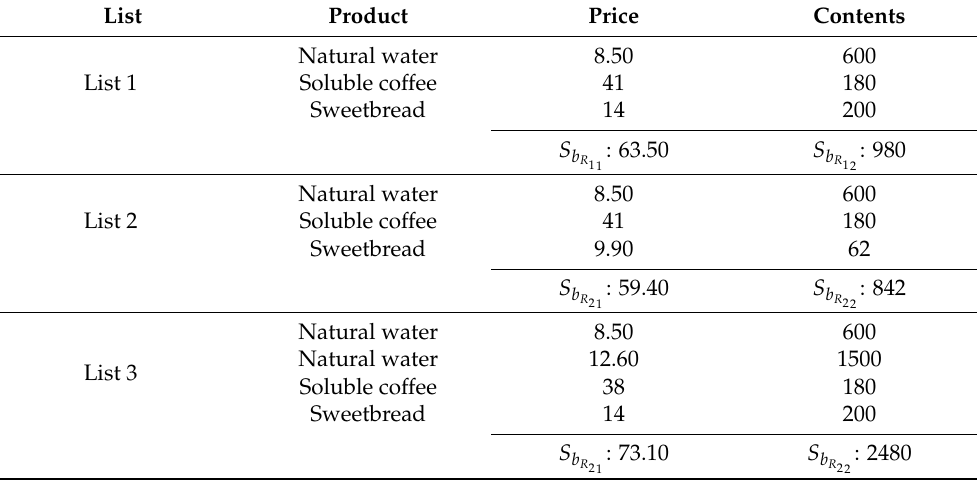
Table 20. Solution alternatives generated with NOSGA-II based on the list in Table 19.